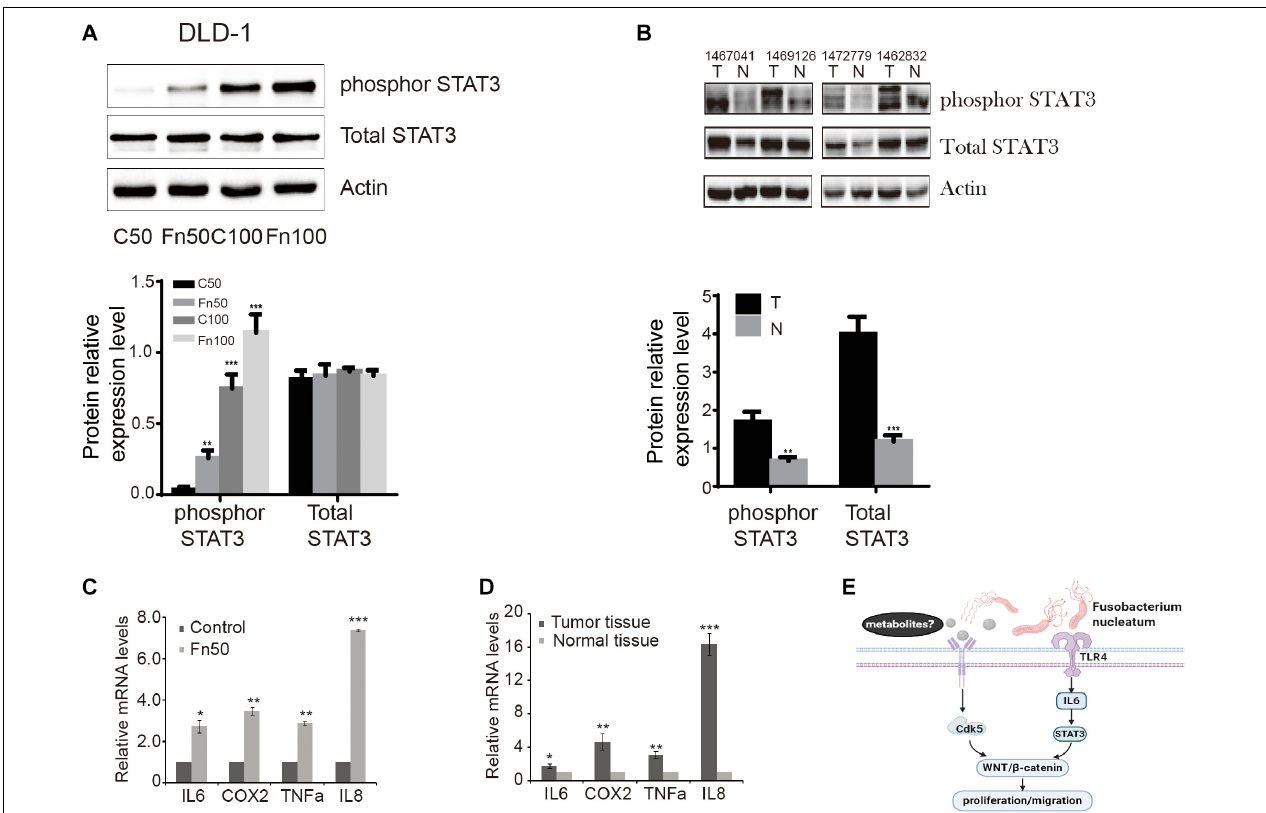
FIGURE 6 | Fusobacterium nucleatum induces the phosphorylation of signal transducer and activator of transcription 3 (STAT3) in cells and tissues. (A) The expression levels and quantification of phosphorylated STAT3 and total STAT3 treated with F. nucleatum were measured by Western blot (WB) analysis in DLD-1 cells. Data are expressed as mean ± SEM from at least three independent experiments. *** P < 0.001 vs. control. (B) The expression levels and quantification of phosphorylated STAT3 and total STAT3 in tumor and normal tissues. Data are expressed as mean ± SEM from at least three independent experiments. ** P < 0.01 and *** P < 0.001 vs. control. (C) Interleukin (IL)-6, cyclooxygenase 2 (COX-2), tumor necrosis factor alpha (TNF- α ), and IL-8 mRNA levels in SW480 cell lines treated with Fn25586. Data are presented as mean ± SEM * P < 0.05, ** P < 0.01, and *** P < 0.001 vs. control. F = 73.872. (D) IL-6, COX-2, TNF- α , and IL-8 mRNA levels in tumor and normal tissues. Data are presented as mean ± SEM * P < 0.05, ** P < 0.01, and *** P < 0.001 tumor tissue vs. normal tissue. (E) Hypothetical model for F. nucleatum -mediated promotion of the proliferation and migration of colorectal cancer